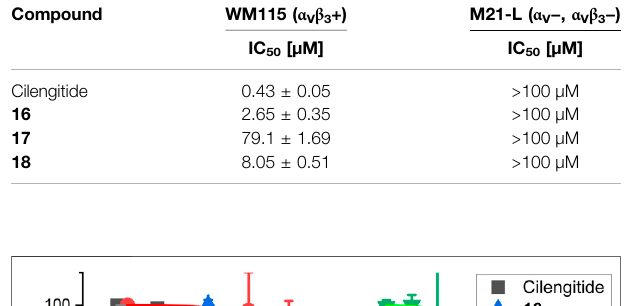
TABLE 7 | Cytotoxicity data with WM115 cells and the calculated targeting index [TI = [IC 50 (17)]/[IC 50 (compound)]]. Compound